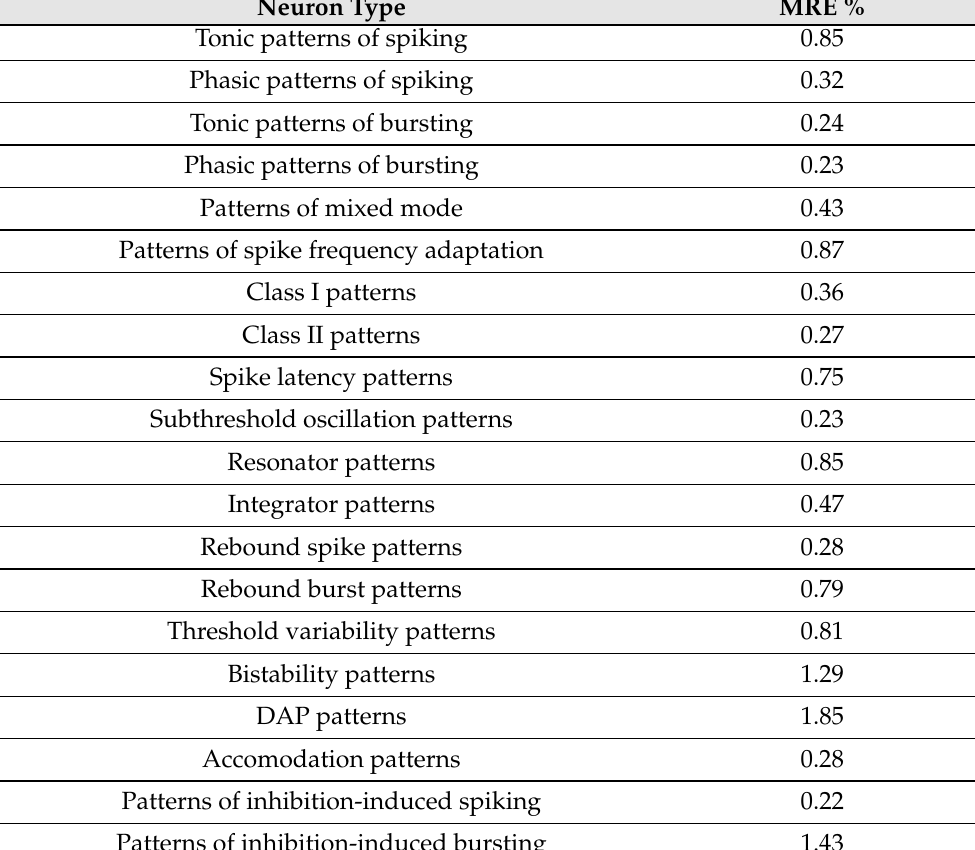
Table 5. Relative error calculations for all firing behaviors of the proposed neuron